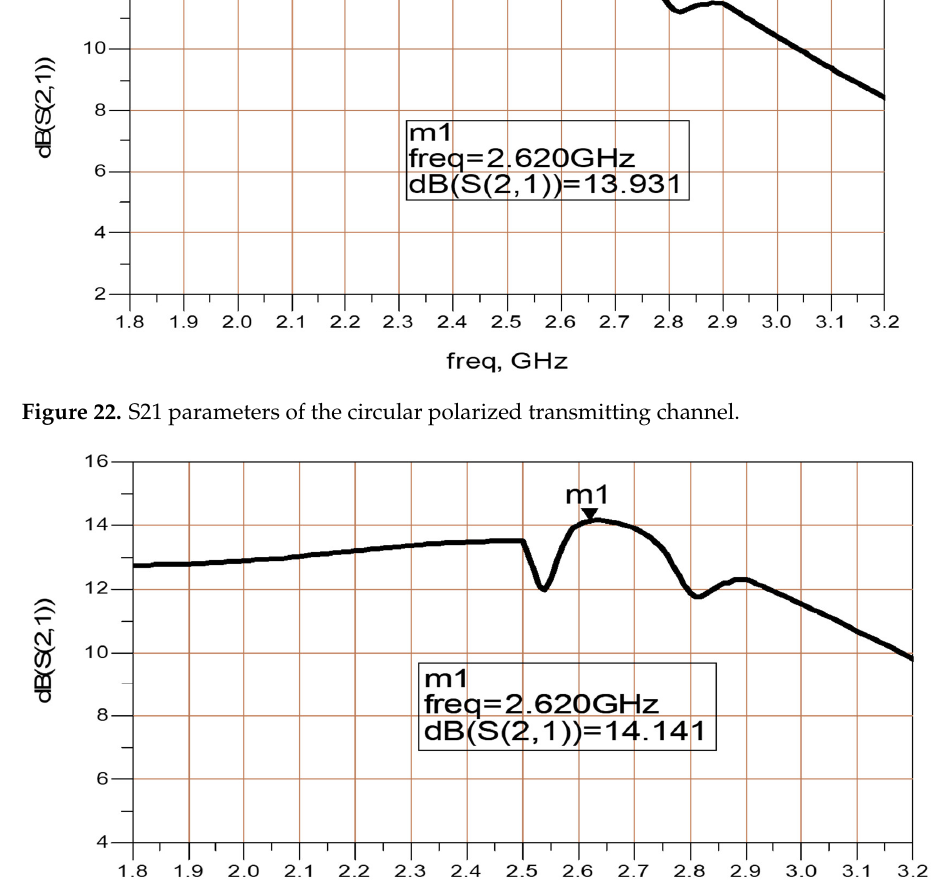
Figure 23. S21 parameters of the circular polarized receiving channel.